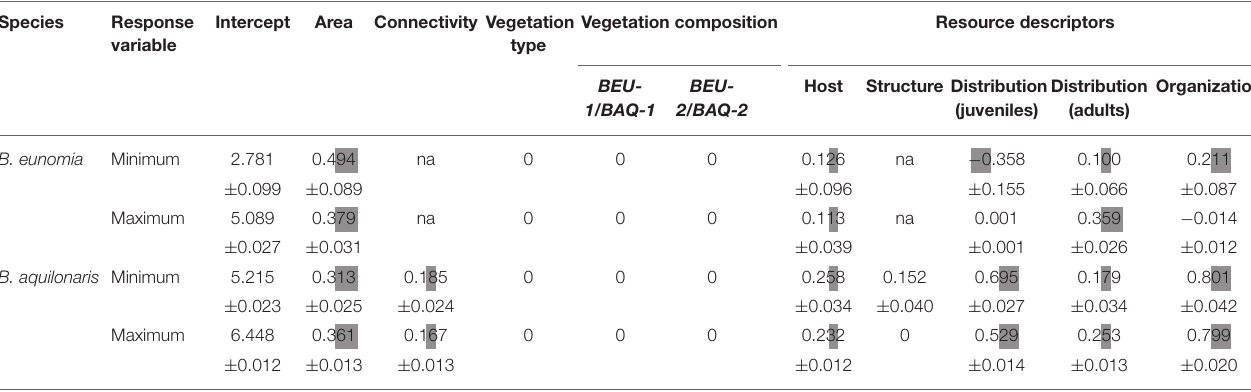
TABLE 3 | Relationship between minimum and maximum population sizes (for B. eunomia and B. aquilonaris ) to habitat parameters represented by slope estimates of linear models.